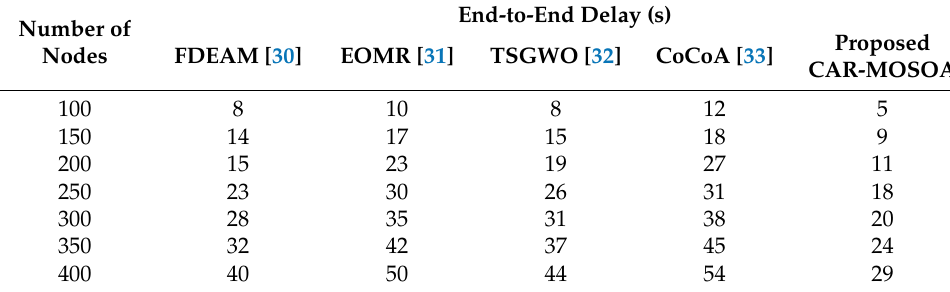
Figure 5. Performance based on end-to-end delay. Table 3. Comparative analysis of end-to-end delay.